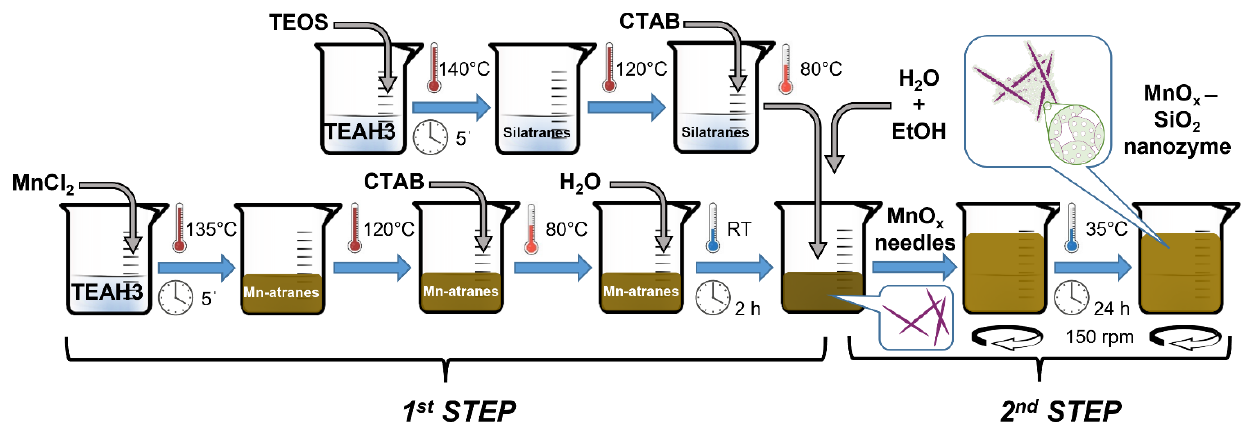
Figure 1. Schematic procedure of the “one-pot” two-step synthesis. The first stage involved, on the one hand, the independent preparation of the respective atrane complexes of silicon and manganese, as well as the hydrolysis and subsequent condensation of the Mn species (for a time of 2 h). The second stage involved the incorporation of the silatrane complexes that hydrolyzed and condensed on the MnO x needles, which acted as seeds on which the formation of mesoporous silica